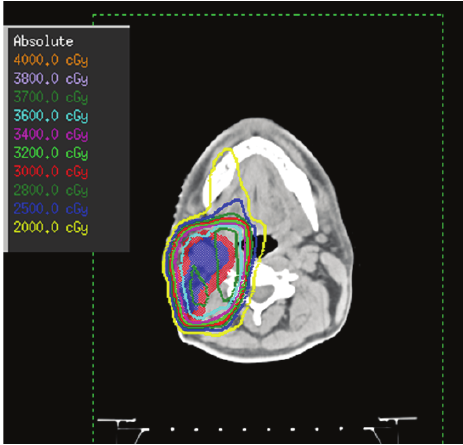
Figure 1: Dose distribution of a three-dimensional conformal radiotherapy: CTV (blue), PTV (red), and isodoses lines of 37 Gray (green), 36 Gray (cyan), 34 Gray (pink), and 20 Gray